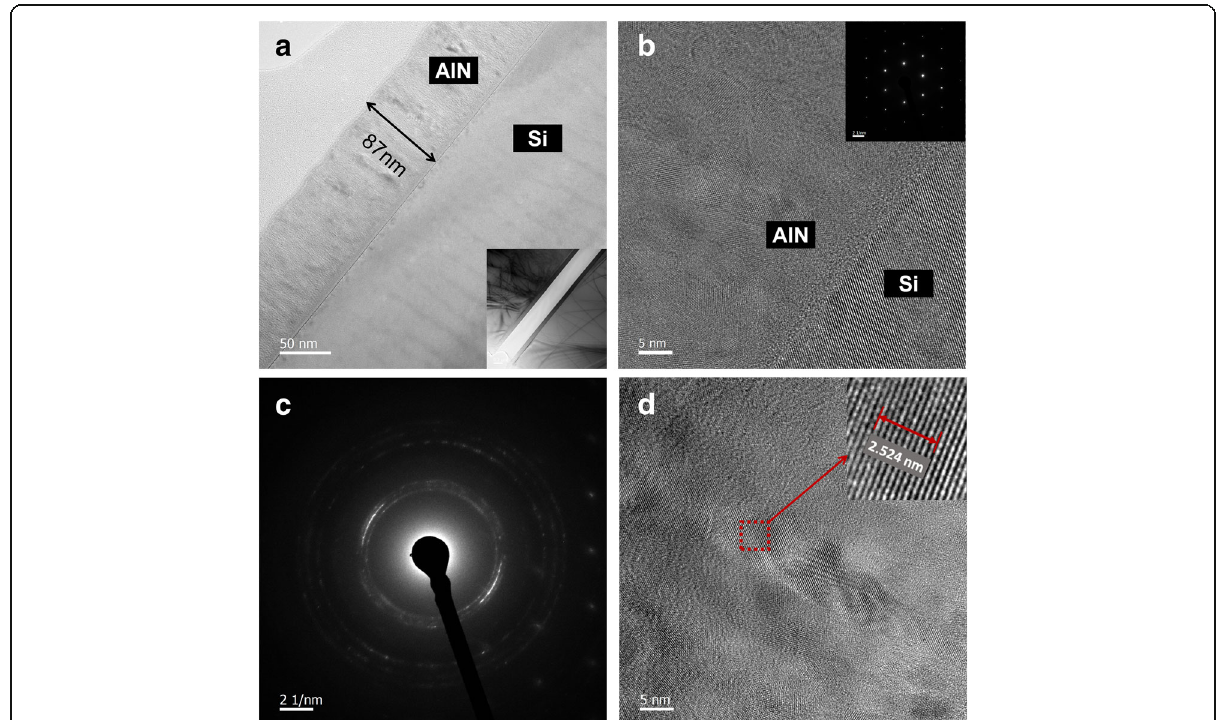
Fig. 6 Cross-sectional TEM images of the 87-nm AlN thin film. a Cross-sectional TEM image and ( inset ) lower magnification cross-sectional TEM image. b Cross-sectional HR-TEM image of the same sample and ( inset ) SAED pattern of Si (100) substrate. c SAED pattern of the same sample. d Cross-sectional HR-TEM image and ( inset ) magnification of the selected square